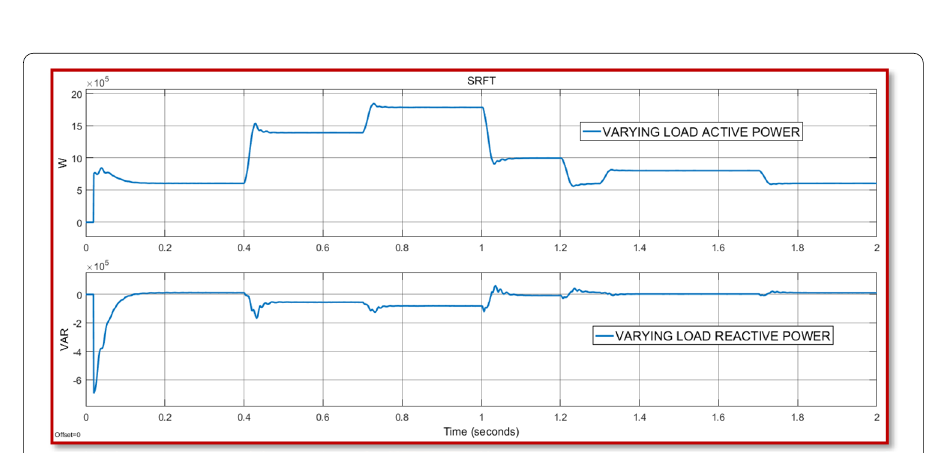
Fig. 17 Varying load of real and reactive